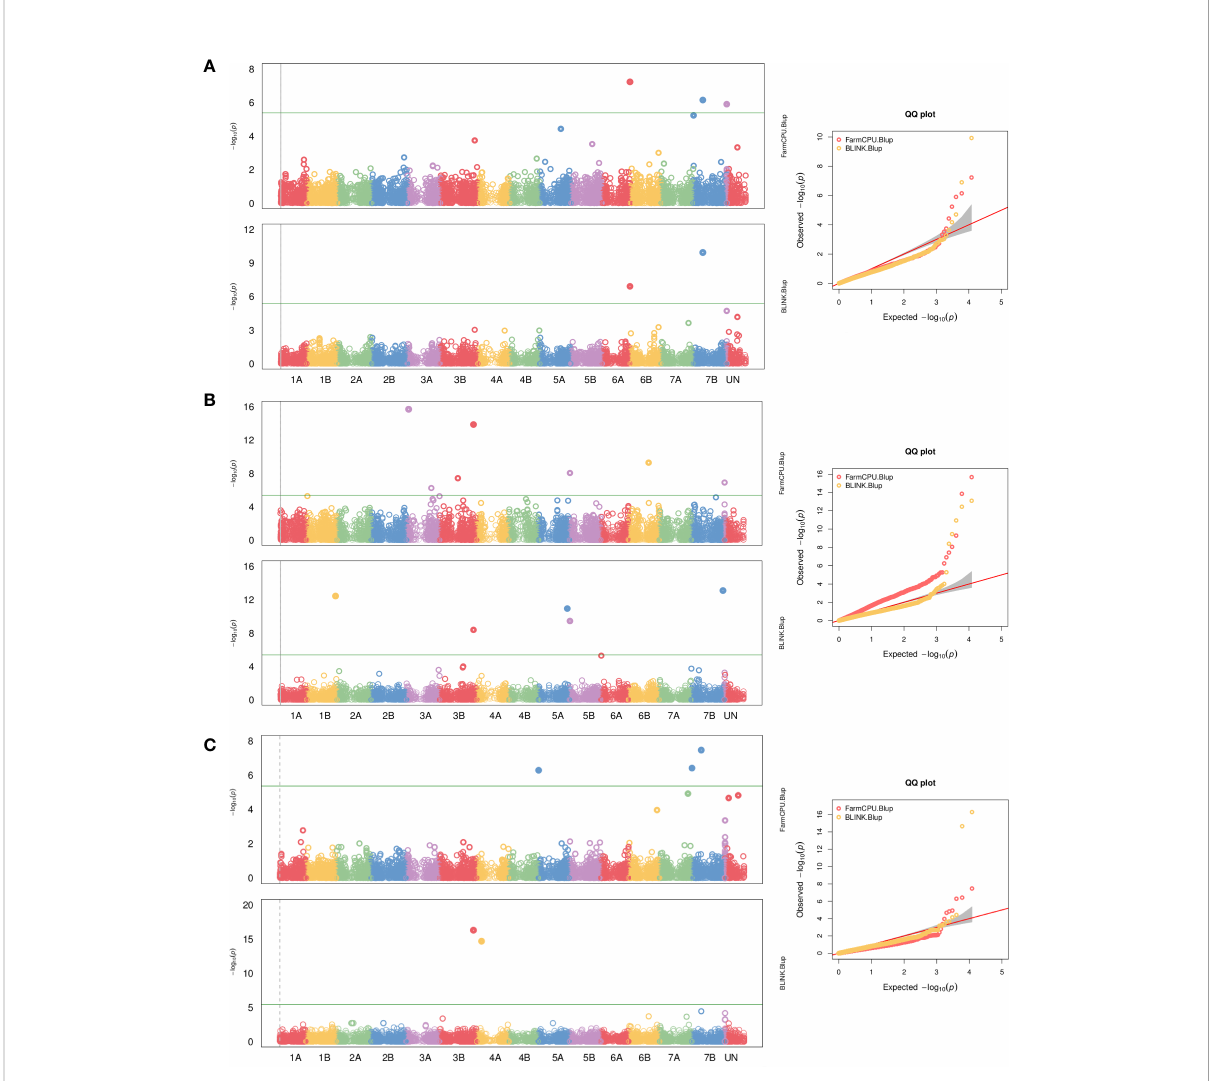
FIGURE 1 Genome-wide association study (GWAS) result plots for heading date in the wild emmer wheat population. Manhattan and Quantile-quantile plots for BLINK and FarmCPU models for data from Italy (A) , Turkey (B) , and for both localities (C) . The signi fi cant threshold (p=0.05) is indicated by the green horizontal